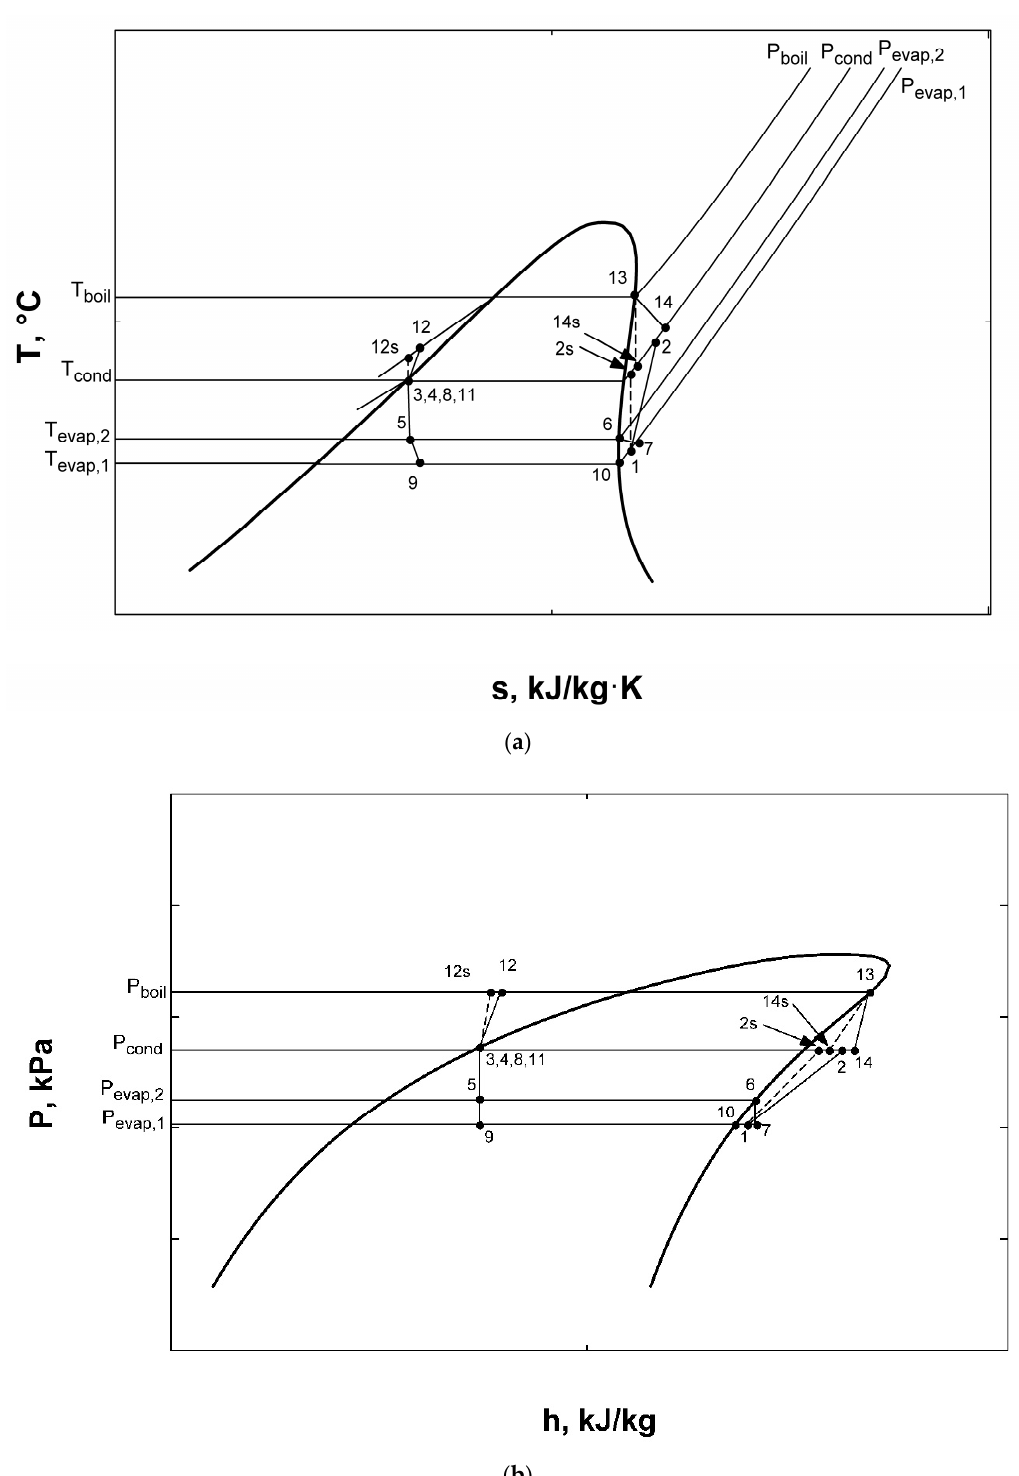
Figure 16. T-s ( a ) and P-h ( b ) diagrams for combined ORC-dual evaporator VCR cycle.